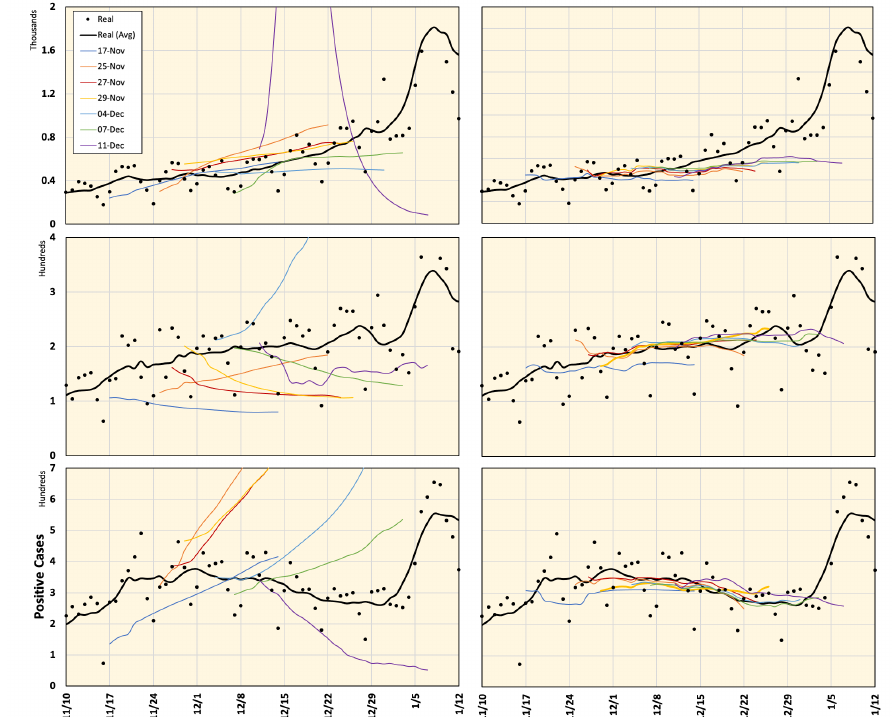
Figure 6. Prediction of COVID-19 positive cases in Tokyo, Aichi, and Osaka (from top to bottom) released by Google Cloud ( left ) and computed using the proposed framework ( right ), compared to actual real data for different time frames defined in Figure 5. All plots represent a 7-day average value.